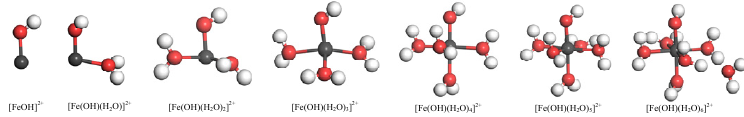
Figure 3. Picture of equilibrium geometry of Fe(OH)(H 2 O) n 2+ ( n = 0–6).